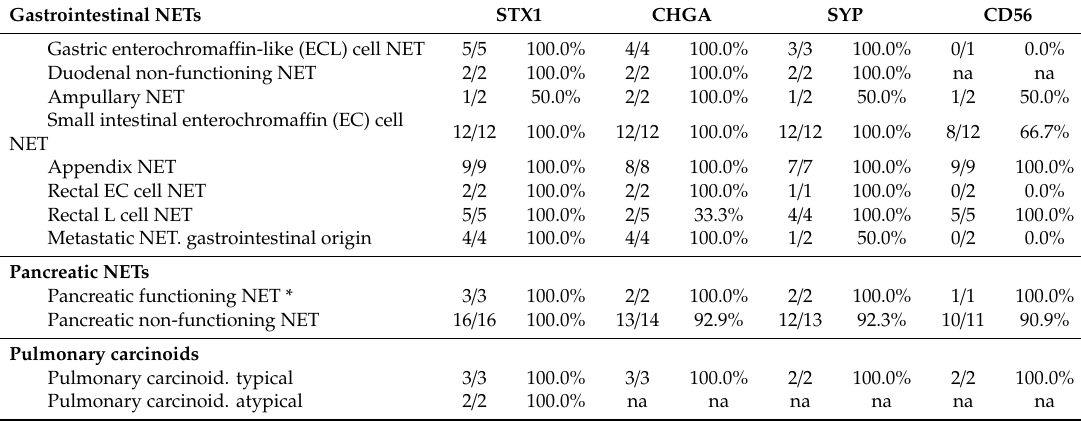
Table 1. STX1, chromogranin A (CHGA), synaptophysin (SYP), and CD56 immunoreactivity of NE neoplasms (NENs) and neuroectodermal / neuroepithelial neoplasms. Gastrointestinal